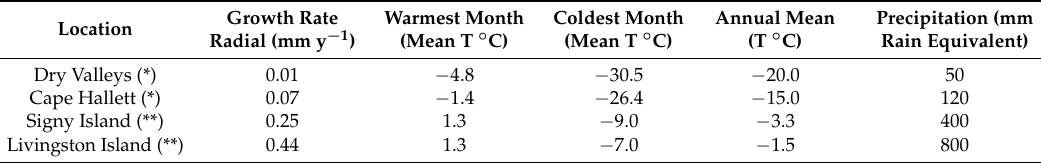
Table 1. Radial growth rate of Buellia (* Buellia frigida ; ** Buellia latemarginata ) species and main climatic parameters from Antarctic localities (Sancho et al. 2007,